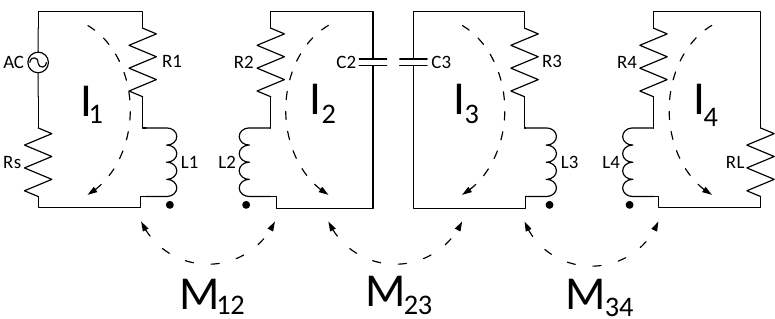
Figure 2. Equivalent hybrid SCMR and CSCMR circuit